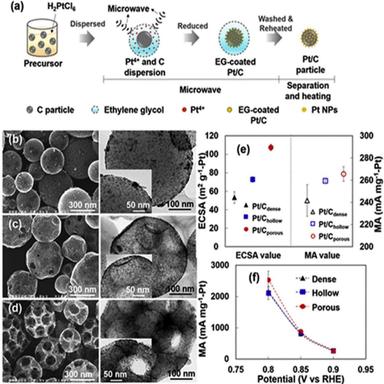
(a) Schematic of the Pt NP deposition process via an EG-assisted microwave method. SEM (left), TEM (right), and HR-TEM (inset) images of (b) Pt/Cdense, (c) Pt/Chollow, and (d) Pt/Cporous catalysts. (e) ECSA and MA values (E ¼ 0.9 V) and (f) MA values at various E of the nanostructured catalysts. Reprinted (adapted) with permission from (AIChE Journal 2016; 62; 440–450). Copyright © 2016 Wiley (.